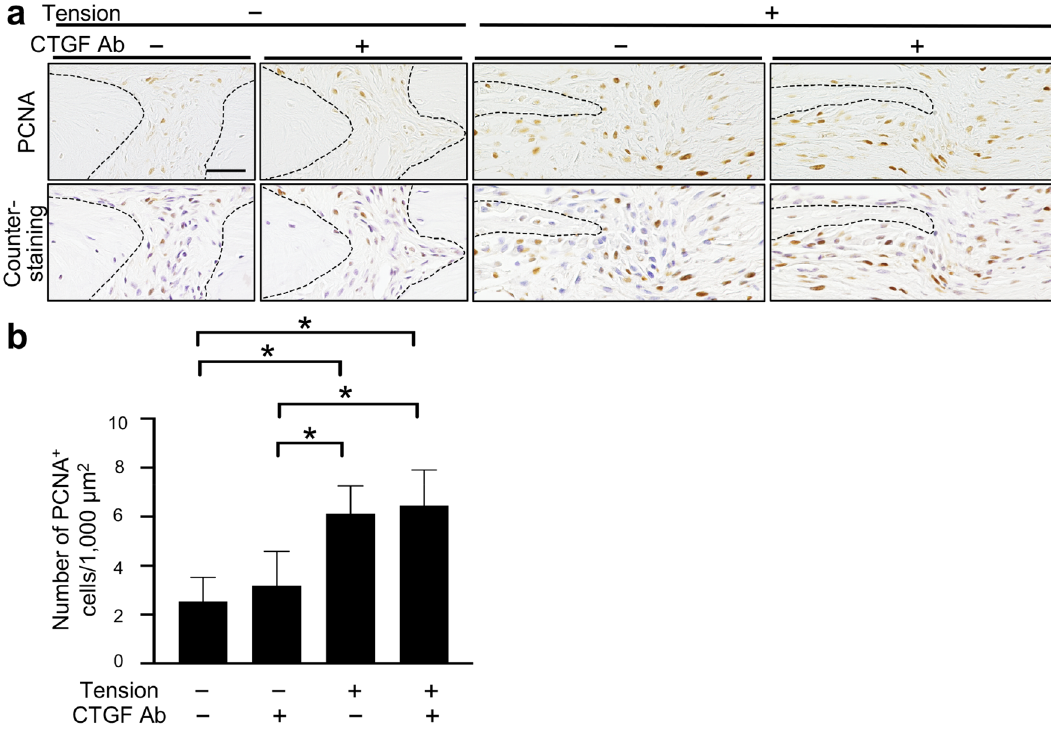
Figure 3. Proliferation was upregulated at the osteogenic front during the tensile force-induced bone formation in a CTGF-independent manner. ( a ) The expression of PCNA at the osteogenic front at 7 days after application of tensile force was analyzed by immunohistochemistry, and counterstaining with hematoxyline was subsequently performed. A 100 μl volume of 10 μg/ml neutralizing CTGF antibody was injected subcutaneously into the parietal bone area every day during the experimental period. The dotted line in the image of immunohistochemistry indicates the border of mineralized bone. ( b ) The number of PCNA + cells at the osteogenic front was evaluated (6 animals per group). CTGF Ab = neutralizing CTGF antibody. Scale bar = 30 μm. *p < 0.05, ANOVA with Tukey–Kramer post hoc